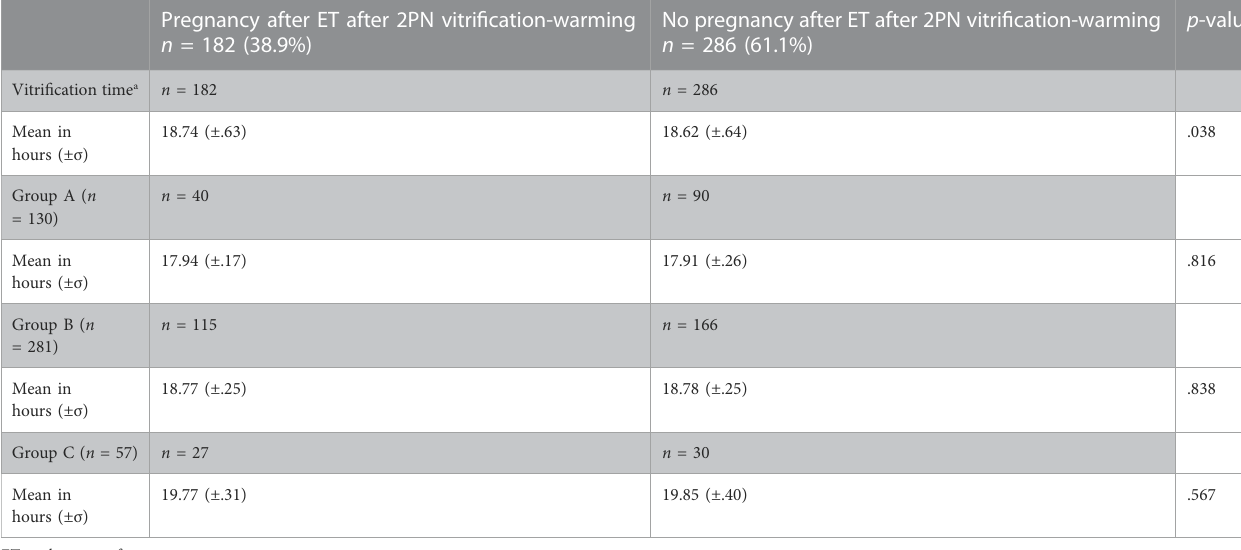
TABLE 5 Overview of hourly